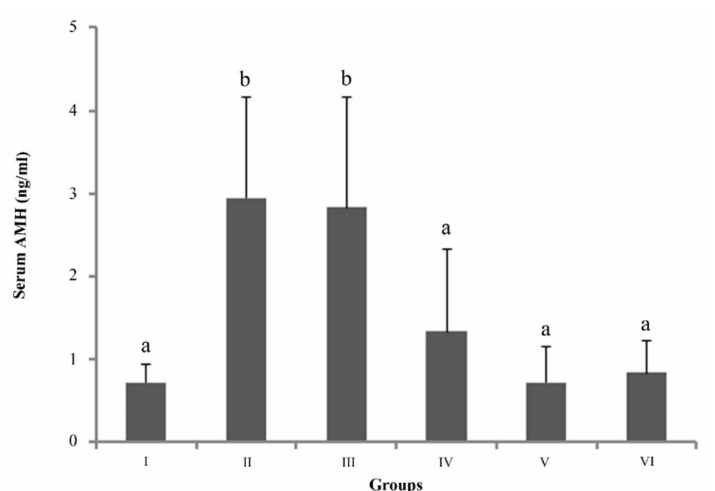
Serum AMH concentrations for group I, II, III, IV, V and VI were 0.72 ± 0.22 ng/mL, 2.95 ± 1.21 ng/mL, 2.83 ± 1.33 ng/mL, 1.34 ± 0.98 ng/mL, 0.72 ± 0.44 ng/mL and 0.84 ± 0.39 ng/mL, respectively (Figure 4). Serum AMH concentration increased signifi- cantly towards mid-gestation, stayed elevated until day 50, and decreased towards term ( p < 0.05). The serum concentration in group II and III was higher than in all other groups ( p < 0.05). There was no correlation between AMH serum concentration and fetus number.